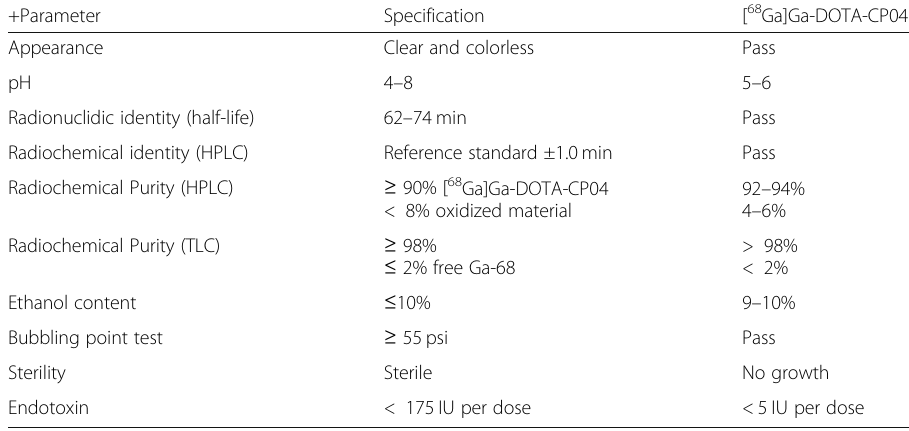
Table 1 Pre-set acceptance criteria of [ 68 Ga]Ga-DOTA-CP04 injection and the observed results